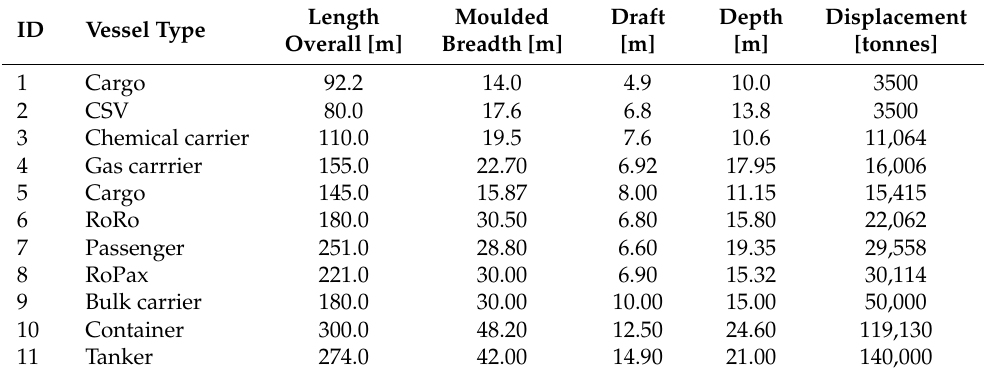
Table 5. Striking ship’s general